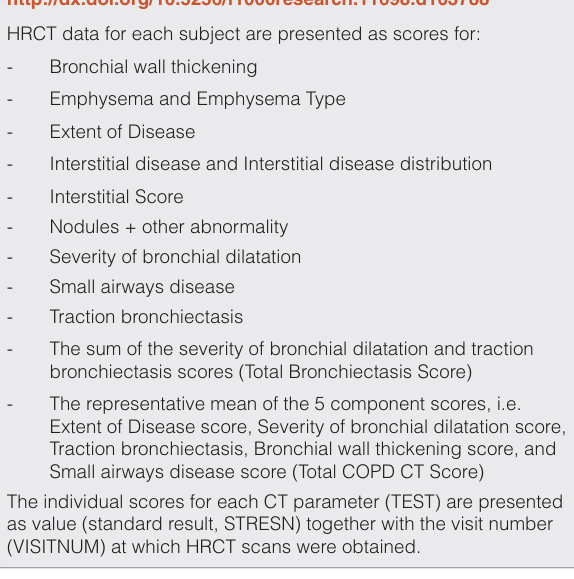
Table of impulse oscillometry data for each subject, including resistance at 5 (R at 5Hz) and 20 Hertz (R at 20Hz), reactance at 5 (X at 5Hz), and Resonant Frequency. The data for each measurement (TEST) are presented as value (standard result, STRESN), together with the visit number (VISITNUM) at which measurements were obtained.